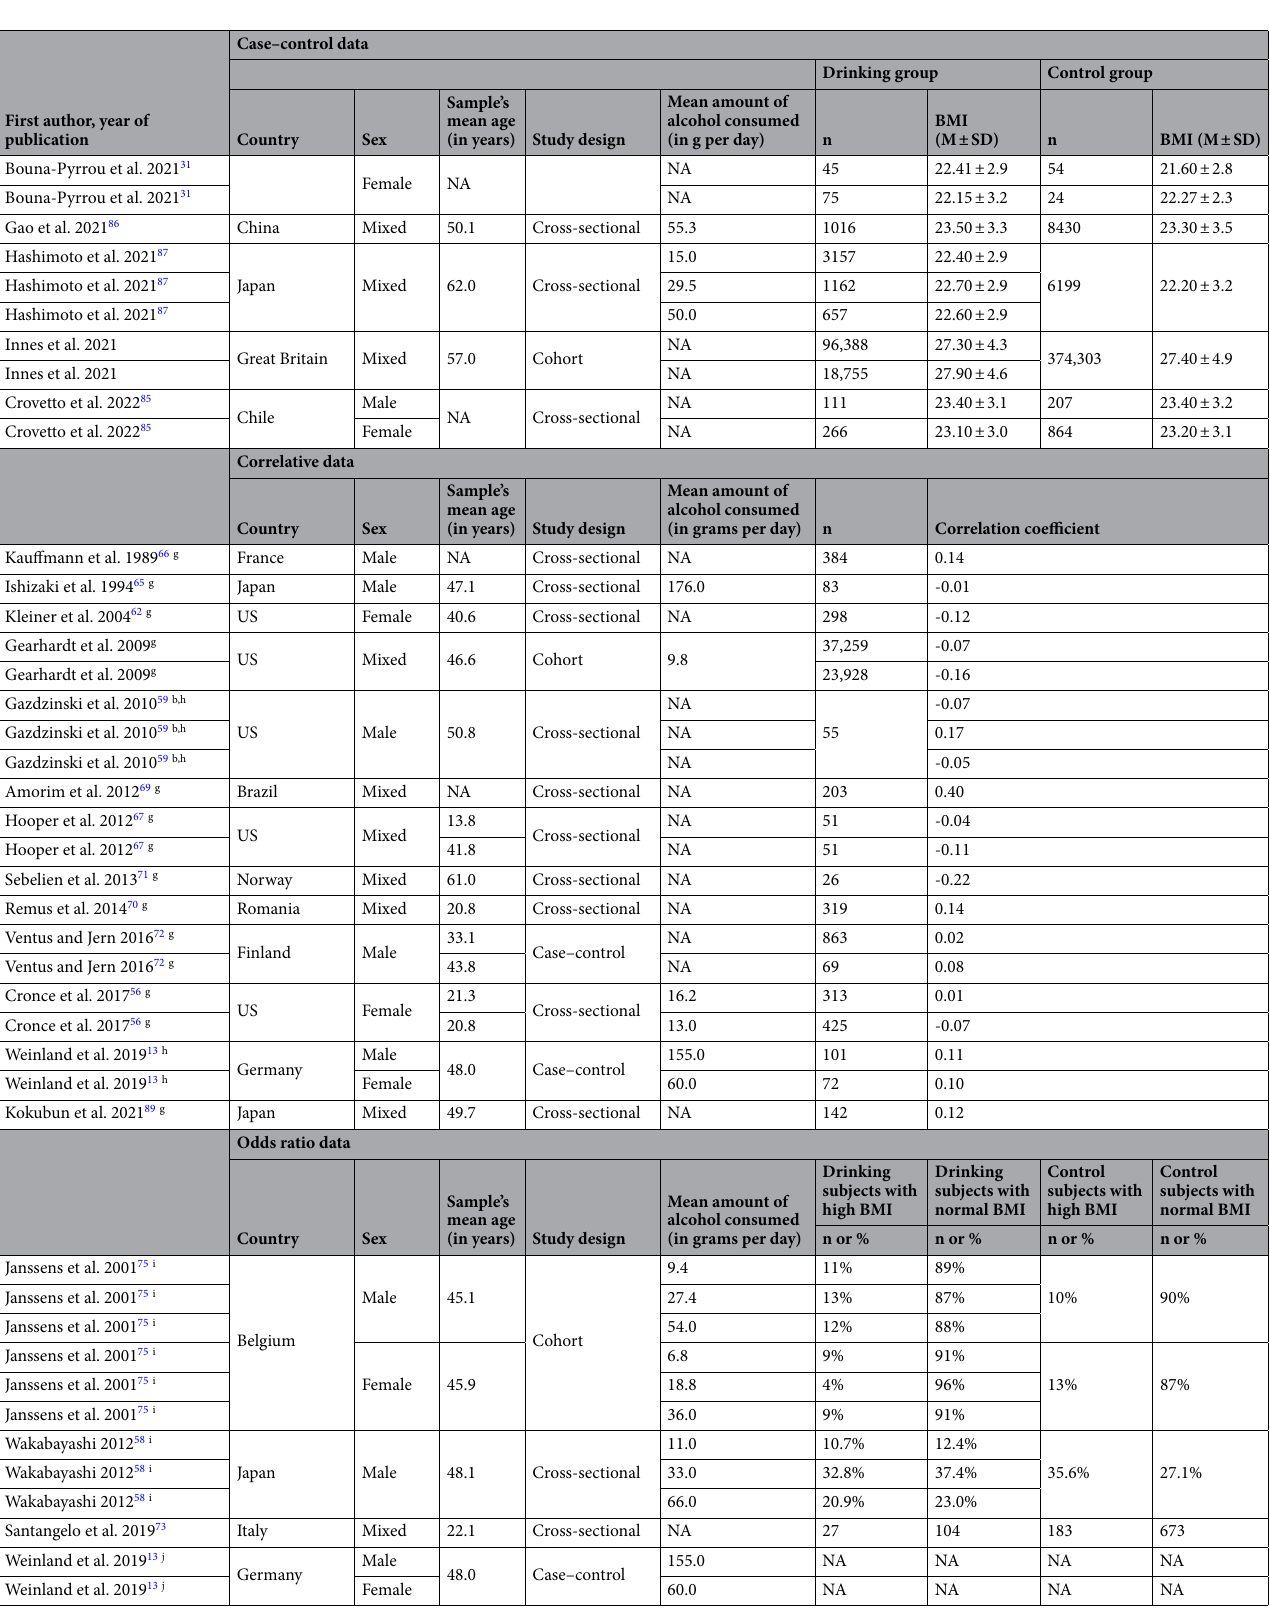
Table 1. Characteristics of all included studies. a Data obtained from graphs. b Data obtained by contacting the authors. c Excluded as outlier in sensitivity analyses. d Standard deviations derived from confidence intervals. e Standard deviations derived from standard errors of the mean. f Standard deviations derived from